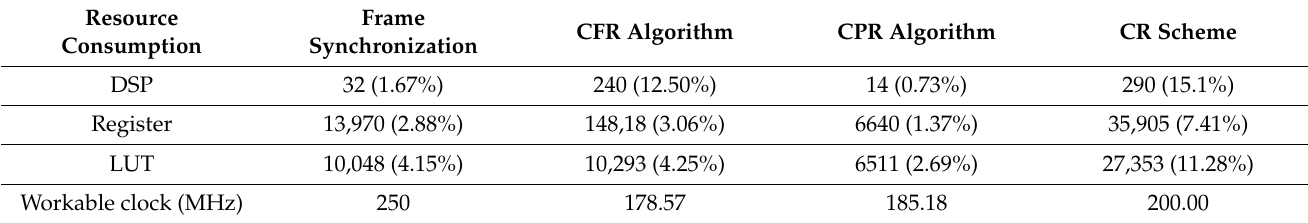
Table 2. Hardware